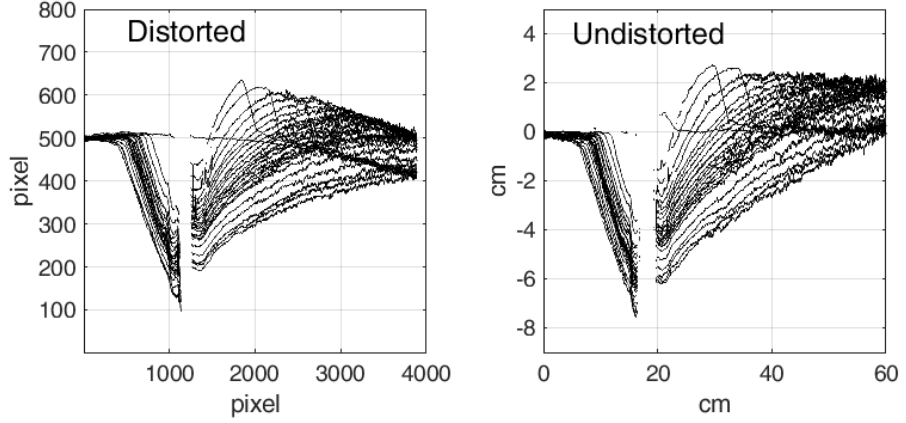
Figure 4. The bottom profiles as originally detected in the photos (distorted and in pixel), left , and after calibration, right .